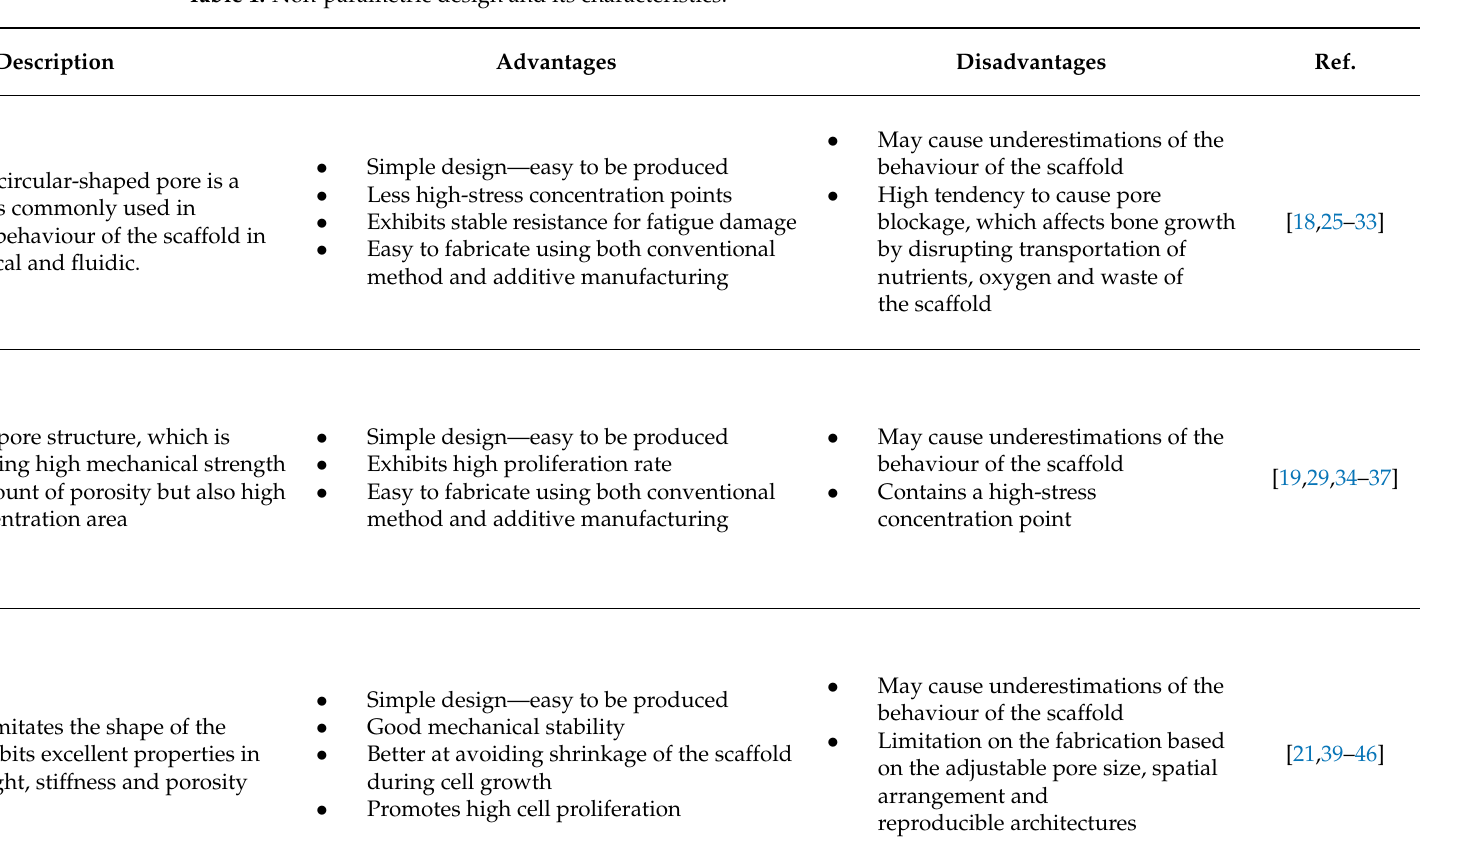
Table 1. Non-parametric design and its characteristics.